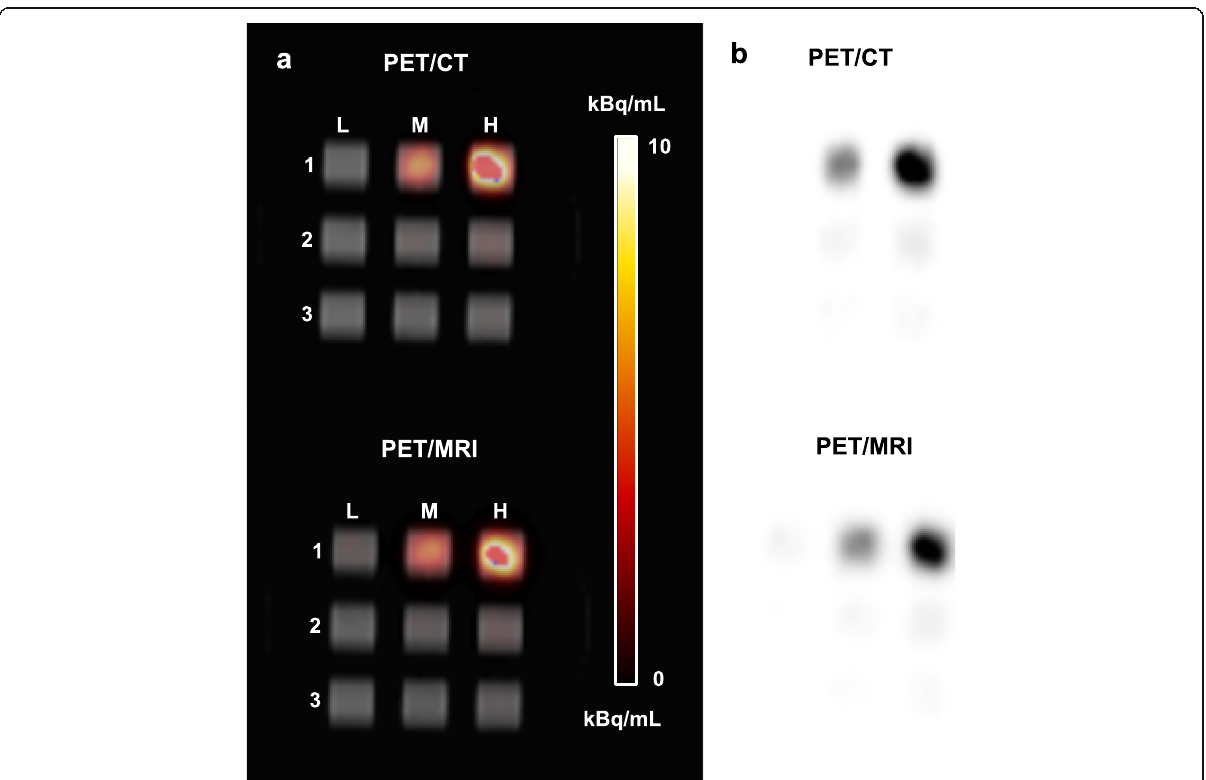
Fig. 5 PET images of 3 × 3 cubic-well plate containing 89 Zr-labeled Jurkat cells suspended in Geltrex ™ matrix in a 1-cm 3 cube acquired using PET/CT and PET/MRI together with their a corresponding co-registered CT image and b in greyscale. Cell numbers and specific activities per well (kBq/10 6 cells; indicated in parenthesis) were as follows: L1: 1.07 × 10 6 (0.67). L2: 1.50 × 10 5 (0.42). L3: 6.70 × 10 4 (0.14). M1: 8.20 × 10 5 (7.23). M2: